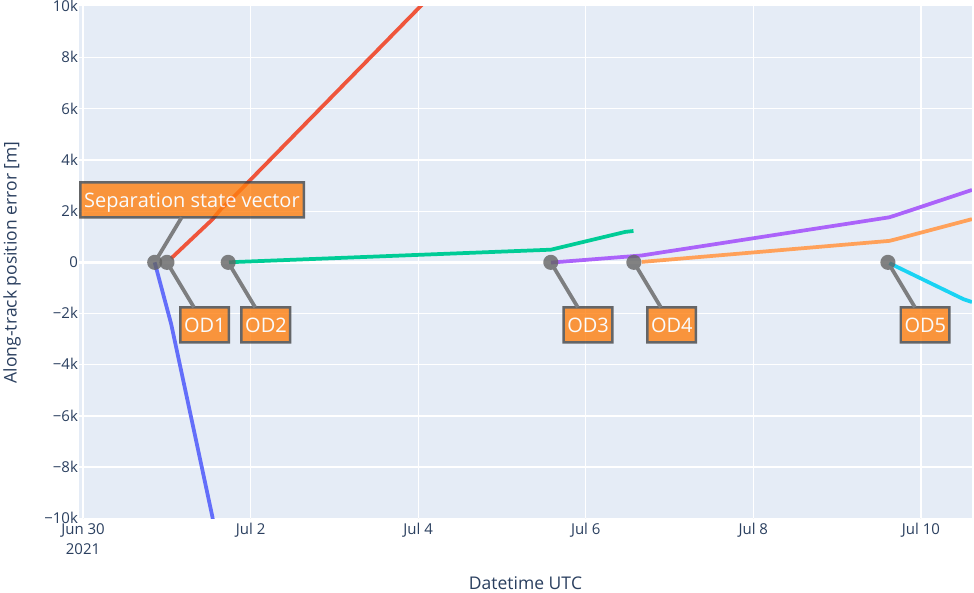
Figure 3. Evolution over time of the along-track error between each prediction and subsequent GPS